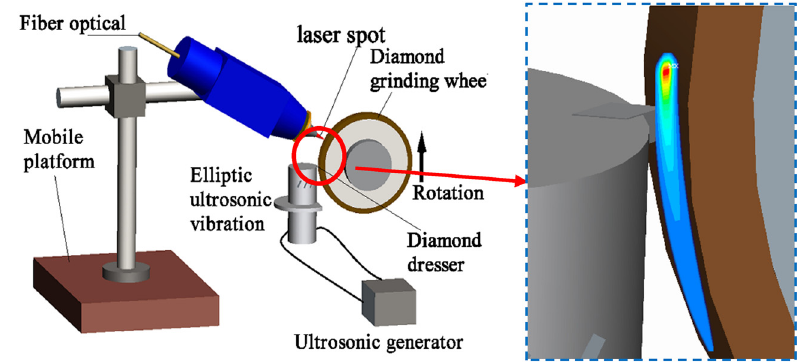
Figure 1: Process of CBN wheel dressed by laser - ultrasonic